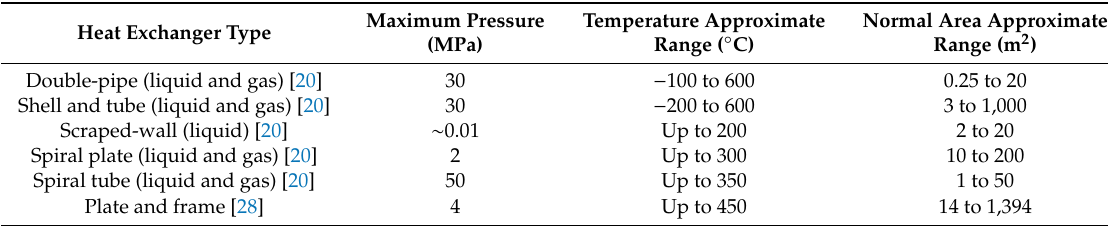
Table 2. Heat exchanger types and their temperature and area ranges.